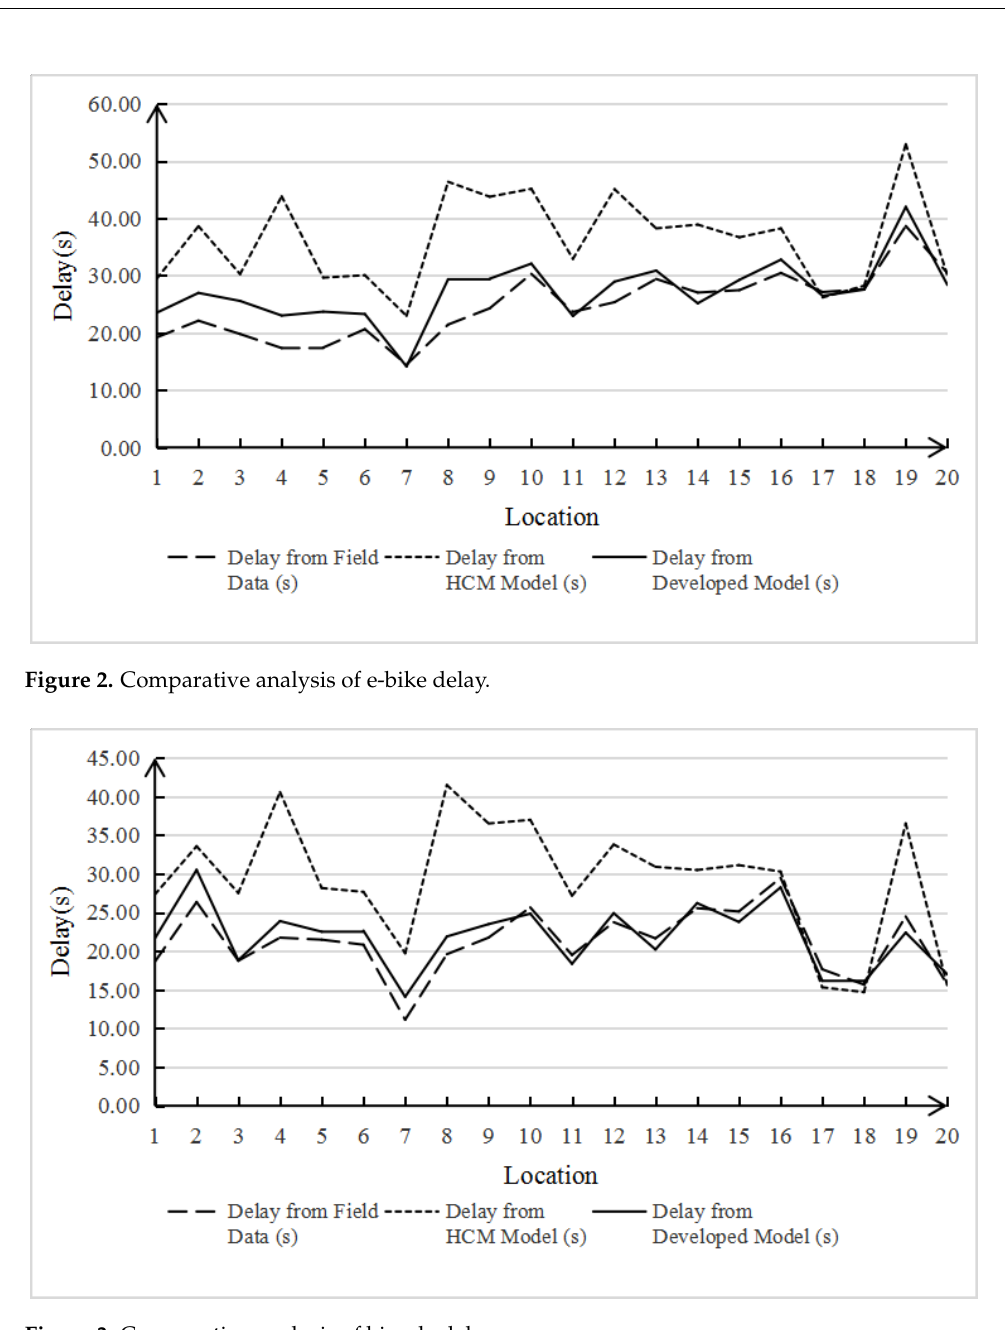
Figure 4. Comparative analysis of the non-motorized vehicle delay. 4. Methodology for LOS Model of the Non-Motorized Vehicle at Signalized Intersec- tion Crossing facilities, traffic conflicts, and delay act as the three main factors which pose an impact on the LOS of the non-motorized vehicles at the signalized intersection. The proposed delay model of the non-motorized vehicle could be used to calculate the average delay at signalized intersections. After choosing the significant factors influencing LOS, statistical methods were used to select the interdependence between model variables and explanatory variables to establish the integration of multiple variables, and thus remove those insignificant variables. 4.1. Questionnaire of Rider’s Perceptions Traffic conditions, crossing facilities, and delays were contained in the site investiga- tion at the signalized intersection. In the field investigation, investigators rode e-bikes and